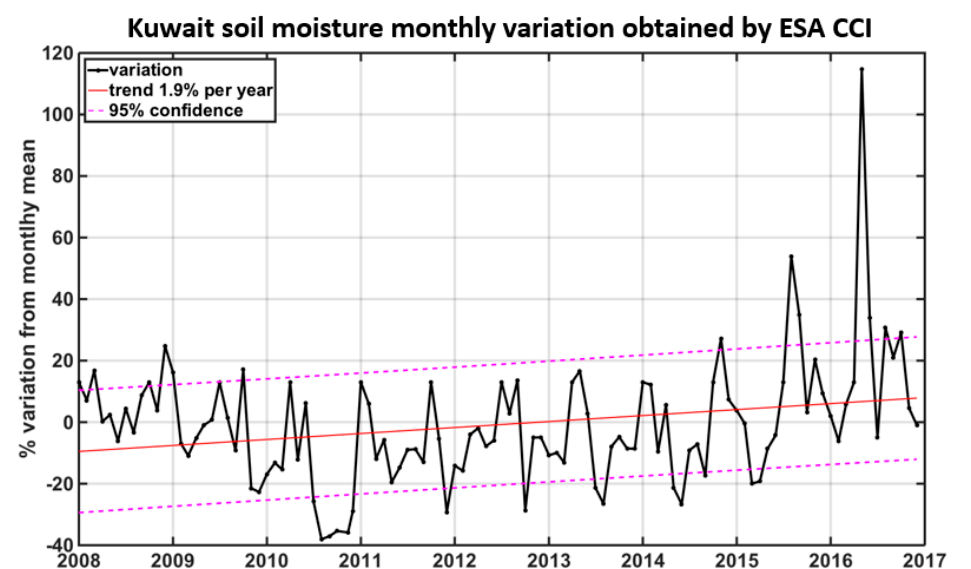
Figure 7. Land cover usage in Kuwait for the years of 2006 and 2010.